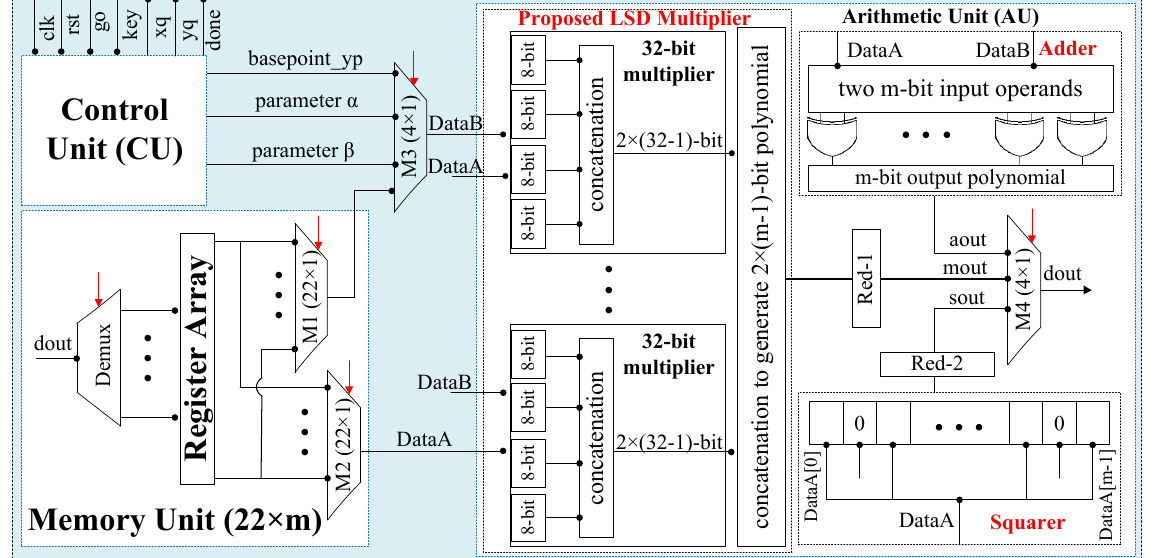
Figure 1. Proposed AREEBA architecture for PM on the BHC